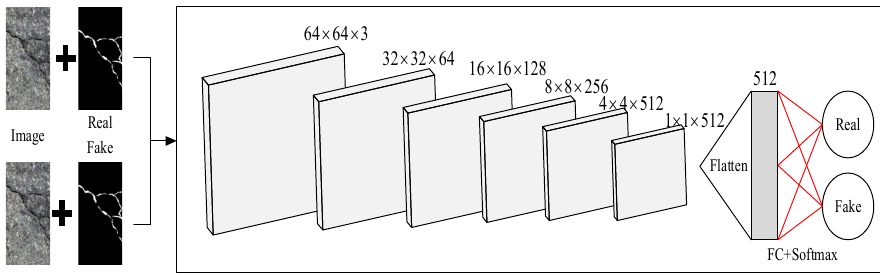
Figure 6. Architecture of the PatchGAN Discriminator.